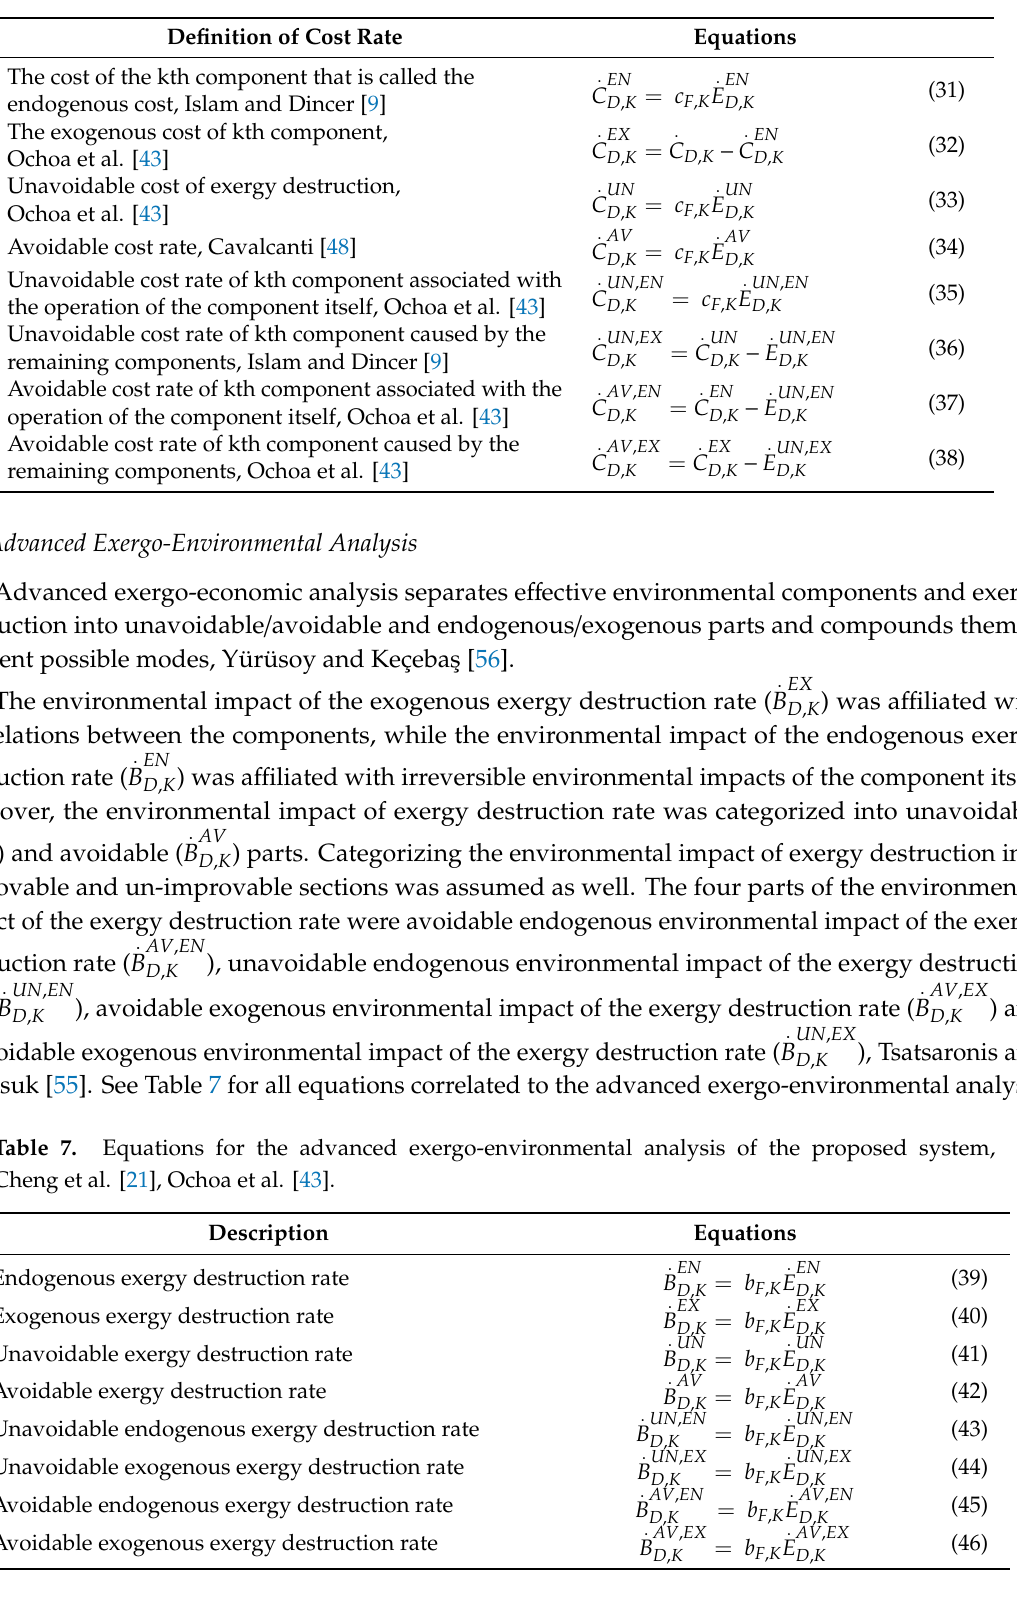
Table 6. Equations for the advanced exergo-economic analysis of the proposed system.